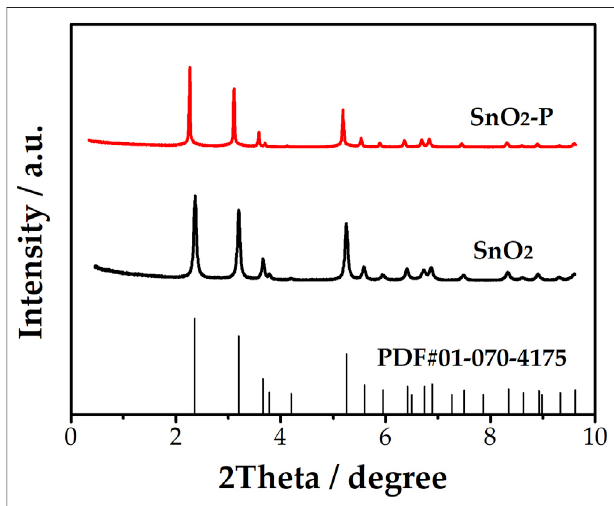
FIGURE 1 | XRD patterns of SnO 2 and SnO 2